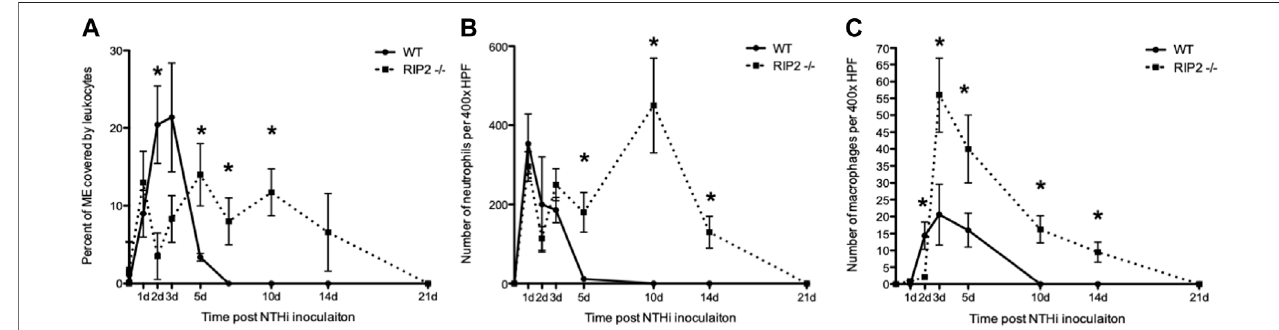
FIGURE6| In fi ltrationoftheMEcavitybyleukocytesafternon-typeable H.in fl uenzae inoculation. (A) AgreaterpercentageoftheMEwasoccupiedbyin fl ammatory cellsinC57BL/6micethaninRIP2 − / − micethrough3 daysafterNTHiinfection.Leukocytein fi ltrationissubstantiallydelayedinRIP2 − / − mice,peakingat5 daysafterNTHi inoculation, and persisting through day 14 (n = 6 – 8 MEs per time point; bars represent the mean ±SEM; * p < 0.05. (B) Leukocyte numbers for neutrophils measured in ME in fi ltrates in wild-type and RIP2 − / − mice. C57BL/6 mice showed peak neutrophil numbers by day 1 after infection with NTHi with no neutrophils evident by day 10afterinfection.Neutrophilsshowedastriking,latein fl uxafterday5,withthepeakatday10andsomeneutrophilsstillpresent14 daysafterinfectioninRIP2 − / − mice(n = 6 MEs per time point; bars represent ±SEM; * p < 0.05). (C) Numbers for macrophages measured in ME in fi ltrates in wild-type and RIP2 − / − mice. Macrophages were recruited to the ME by 2 days after NTHi infection in C57BL/6 mice, with no macrophages noted by day 10 after infection. The RIP2 − / − mice had a short delay in macrophage recruitmentby day 2 after infection but displayed prolonged macrophage presence in the ME until 21 days after non-typeable H. in fl uenzae (n = 6 MEs per time point; bars represent ±SEM; * p < 0.05).